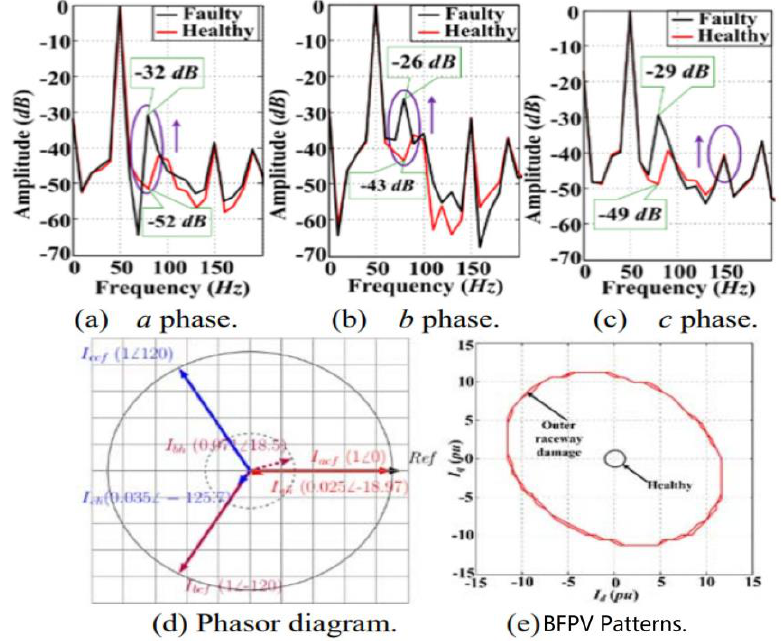
Figure 8. The impact of outer raceway fault on ( a ) phase a ( b ) phase b, ( c ) phase c, ( d ) overall phasor diagram, ( e ) bearing fault Park’s vector (BFPV) [19].